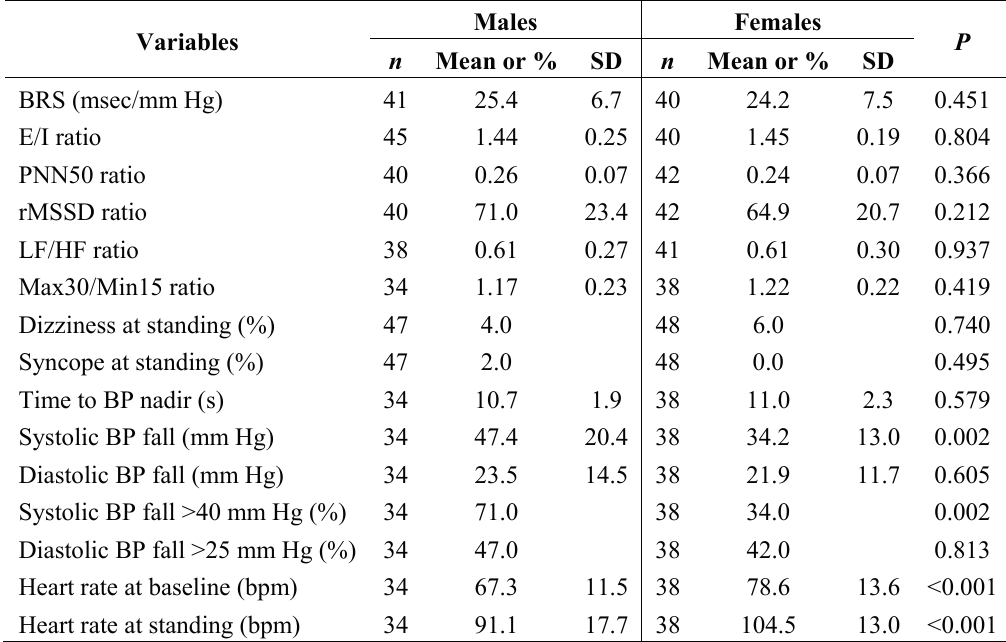
Table 2. Baroreflex sensitivity, heart rate variability and initial orthostatic hypotension in young healthy adults in the